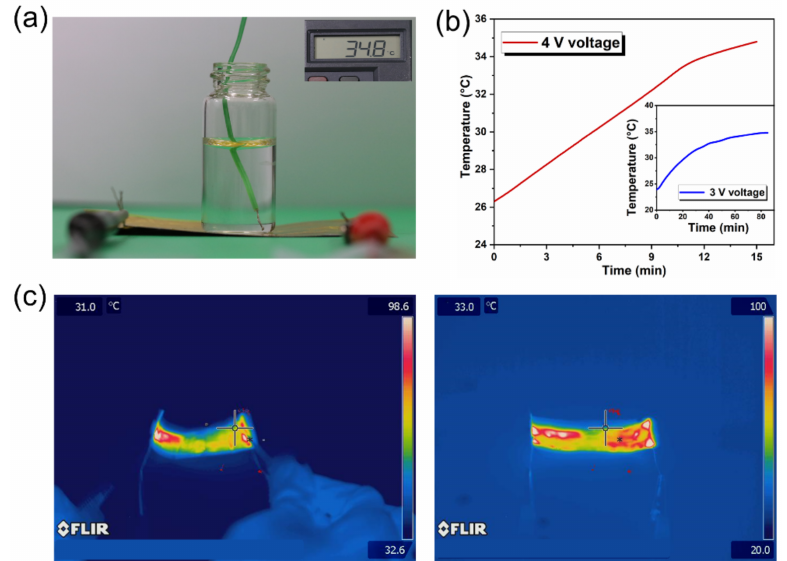
Figure 10. ( a ) The device for the measurement of heating feature. ( b ) Curve of time required to reach different voltages at the same temperature. ( c ) Infrared images of electrothermal feature after liquid nitrogen